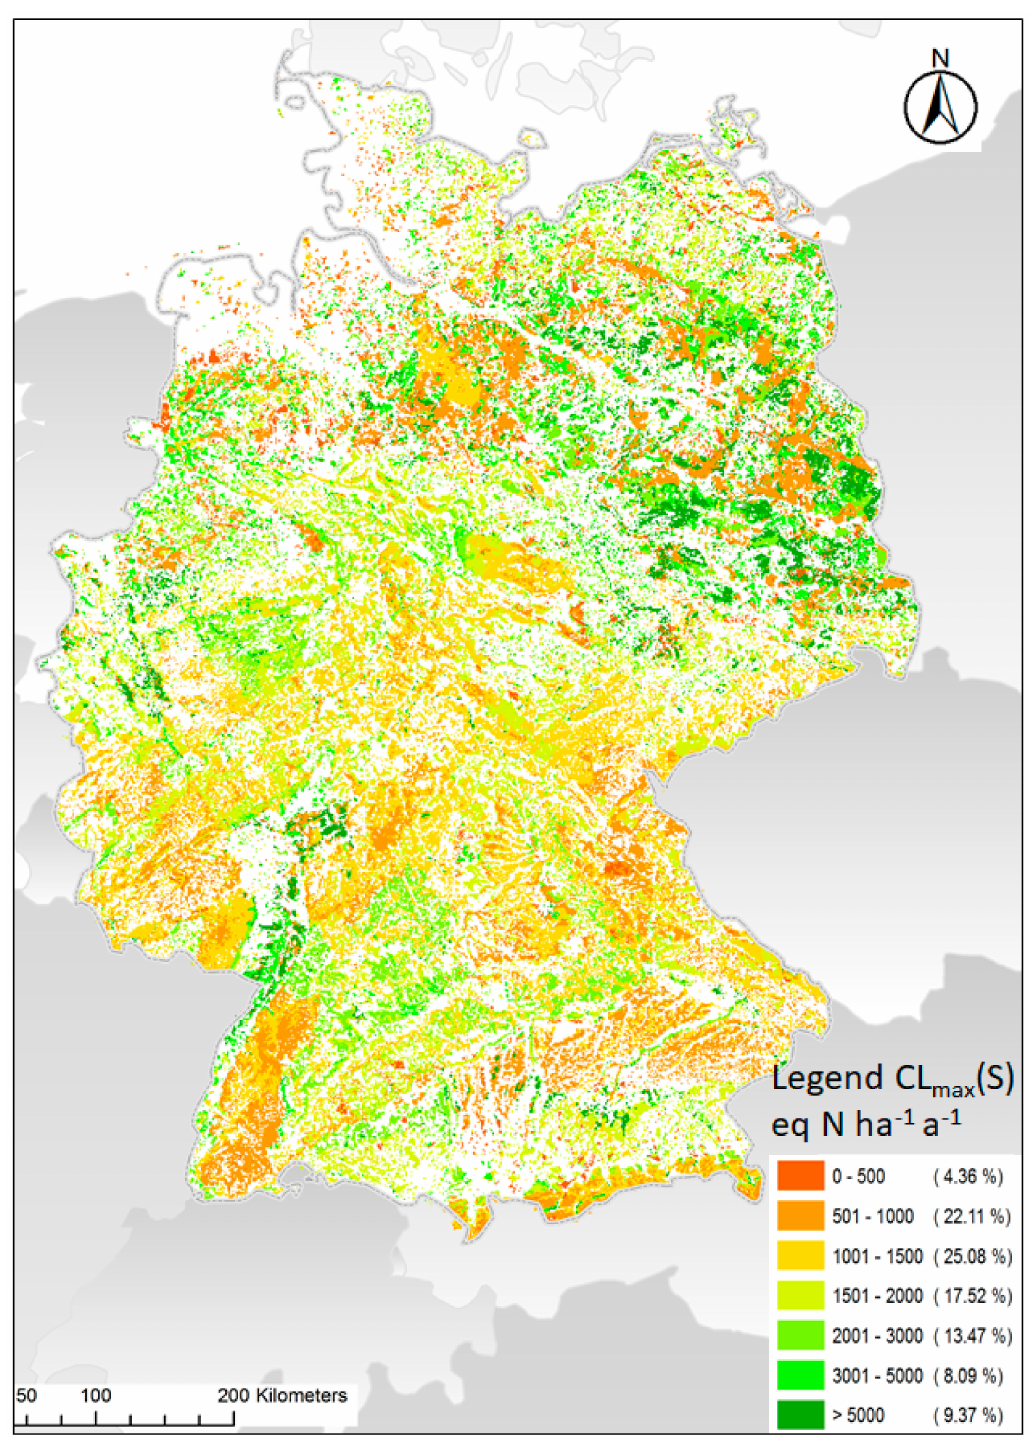
Figure 5. Critical loads for acidifying sulphur inputs, created by the authors. The near-natural and semi-natural ecosystems in Germany are predominantly signifi- cantly more sensitive to eutrophying nitrogen inputs (Table 22) than to acidifying sulphur inputs (Table 23). Almost 53% of receptor areas have CL nut (N) up to 10 kg N ha − 1 a − 1 . However, these are the pure coniferous stands, which are particularly sensitive and (still) dominate with about 50% of Germany’s forest area